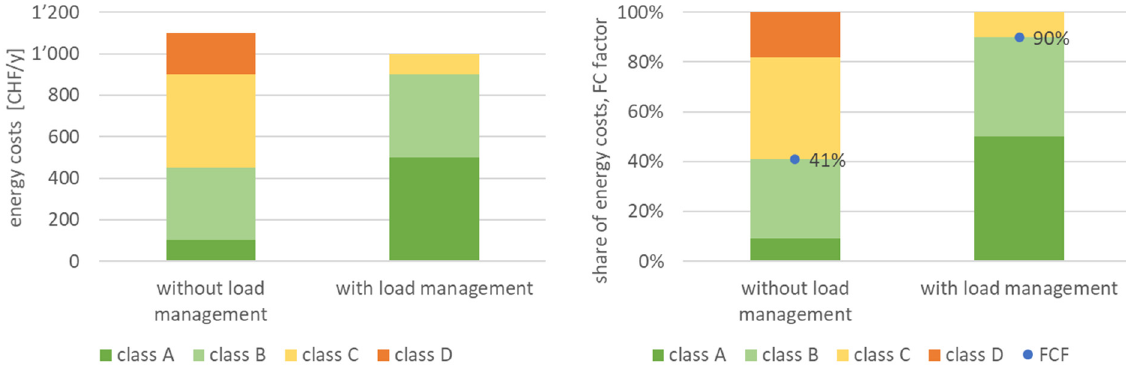
Figure 9. Example for flexibility classification of energy costs ( left : absolute values, right relative values). The right side includes the FC factors.